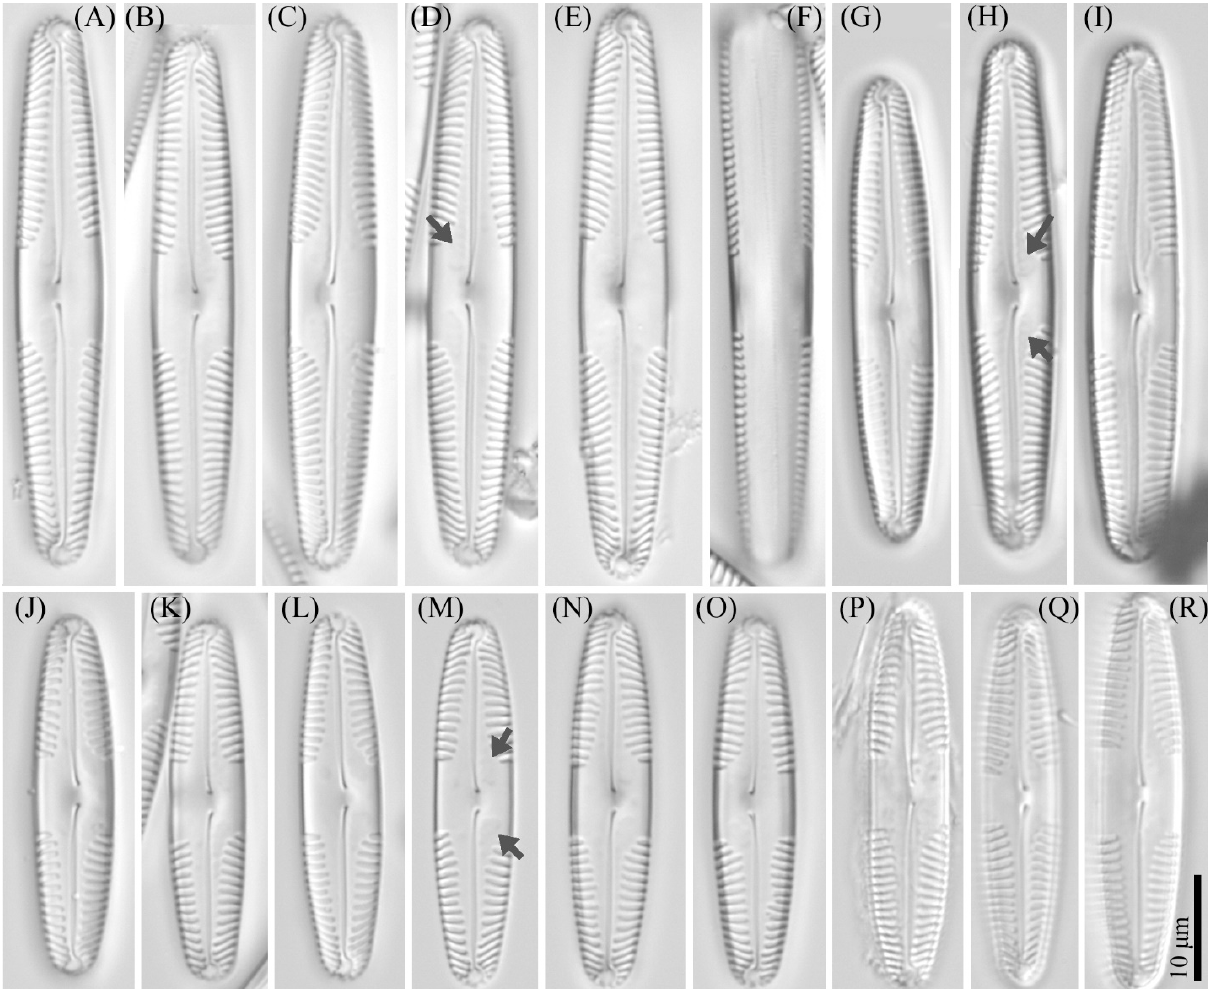
Figure 5. Pinnularia vietnamogibba Kezlya, Maltsev, Krivova et Kulikovskiy sp. nov. Strains VP294 slide No. 07052, VP290. slide No. 07048. Light microscopy, differential interference contrast. ( A – E ) Strain VP294, valve face (arrows indicate the ghost striae). ( J – O ) Strain VP290, valve face (arrows indicate the ghost striae). ( F ) С ell in girdle view. ( A ) Holotype. ( G – I , P – R ) Valves from the wild sample.